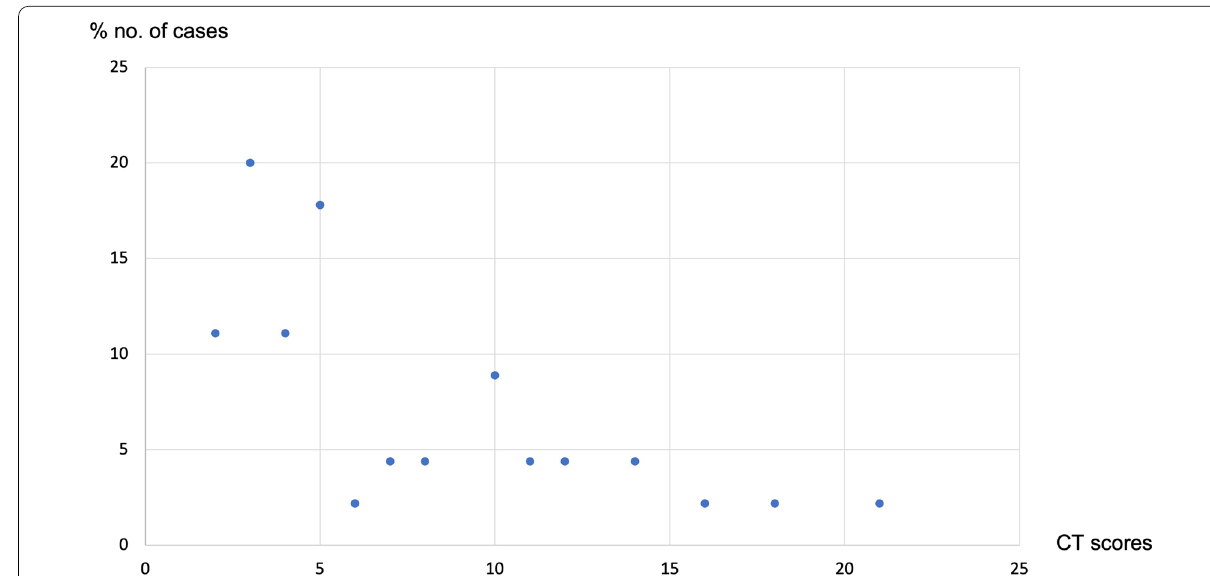
Fig. 1 XY chart showing the percentage values of various CT scores for all diseases